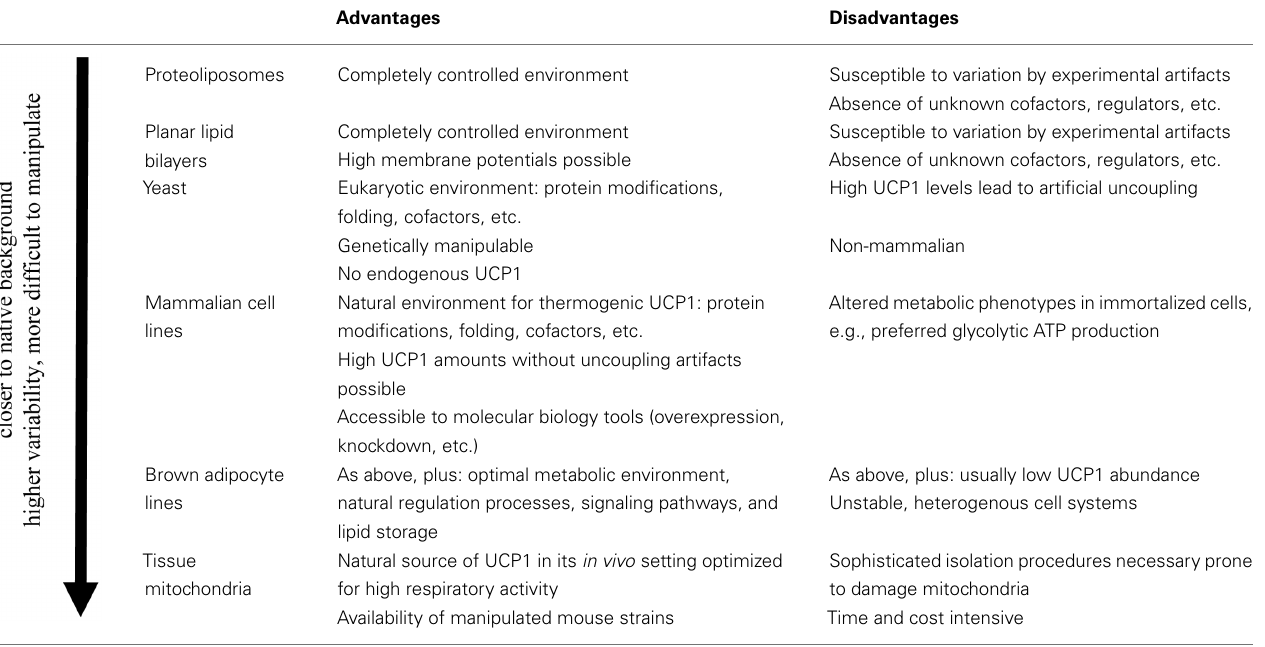
Table 2 |Advantages and disadvantages of different UCP1 test